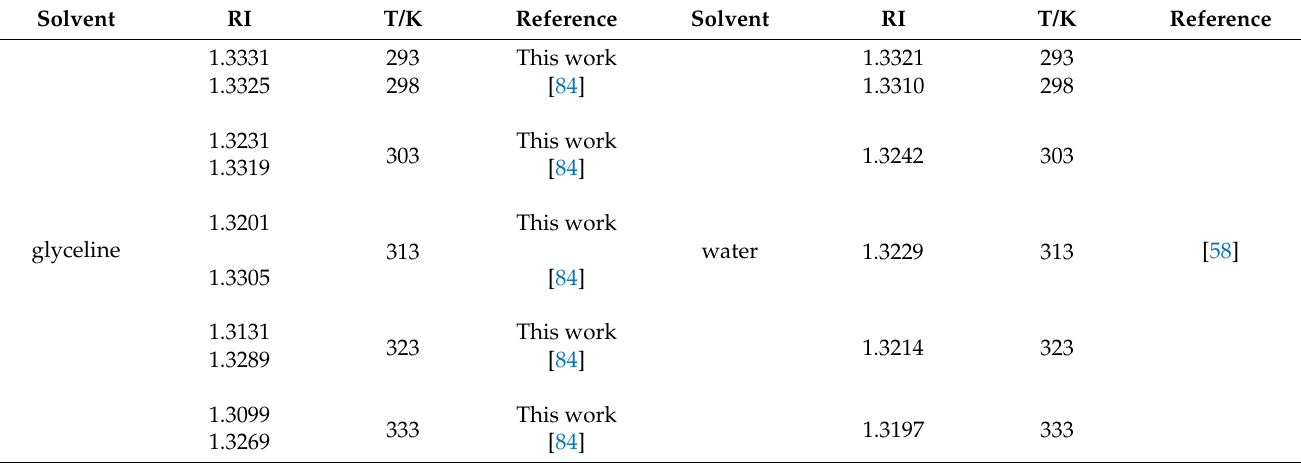
Table 11. Refractive index values for glyceline and water at different temperatures (published and obtained